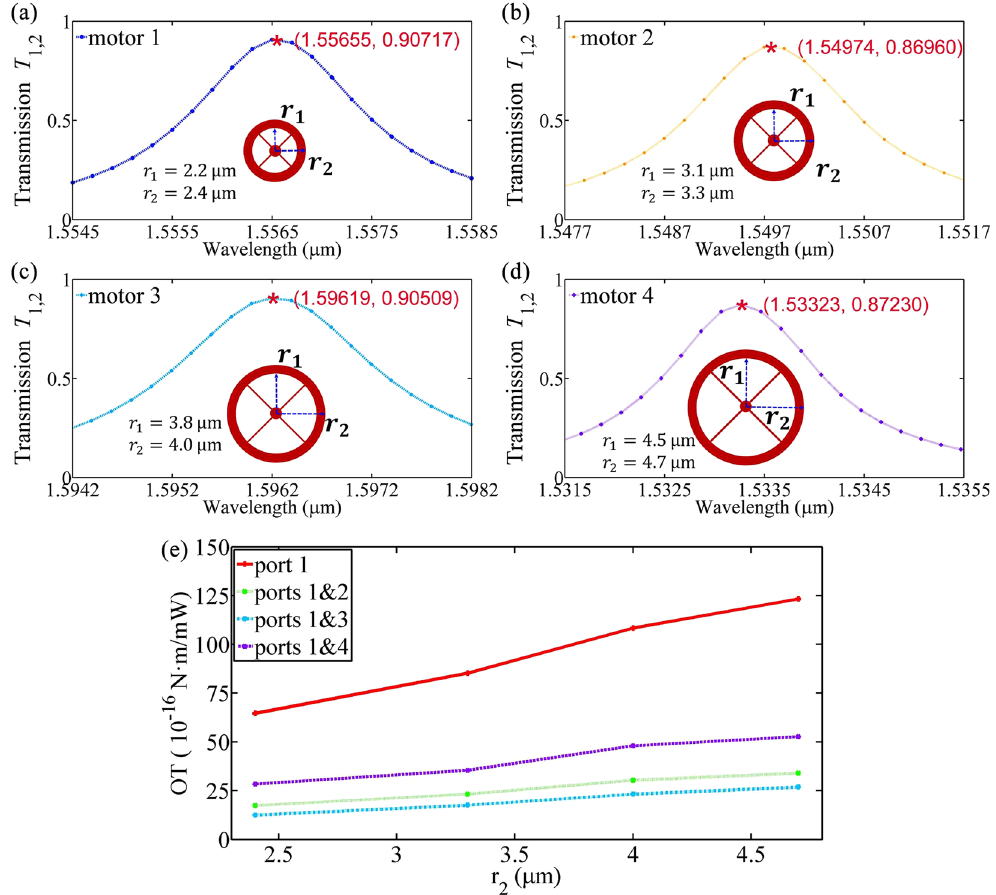
Figure 6. Optical torque versus the radius of the ring resonator. All other parameters, including the refractive index, width of the waveguide and ring, and the gap between them, are the same as those in Fig. 2(a–d). Transmission curve T 1,2 of the four different ring resonators with radiuses of 2.4 μ m, 3.3 μ m, 4.0 μ m and 4.7 μ m, respectively, and the peak value coordinate are labeled by red stars, which show that the resonant wavelength λ 01~04 are 1.55655 μ m, 1.54974 μ m, 1.59619 μ m, 1.53323 μ m and the peak transmission of motor 1~4 are 0.90717, 0.86960, 0.90509, 0.87230, respectively. ( b ) OT peak values changes with the radius of the ring resonator for different